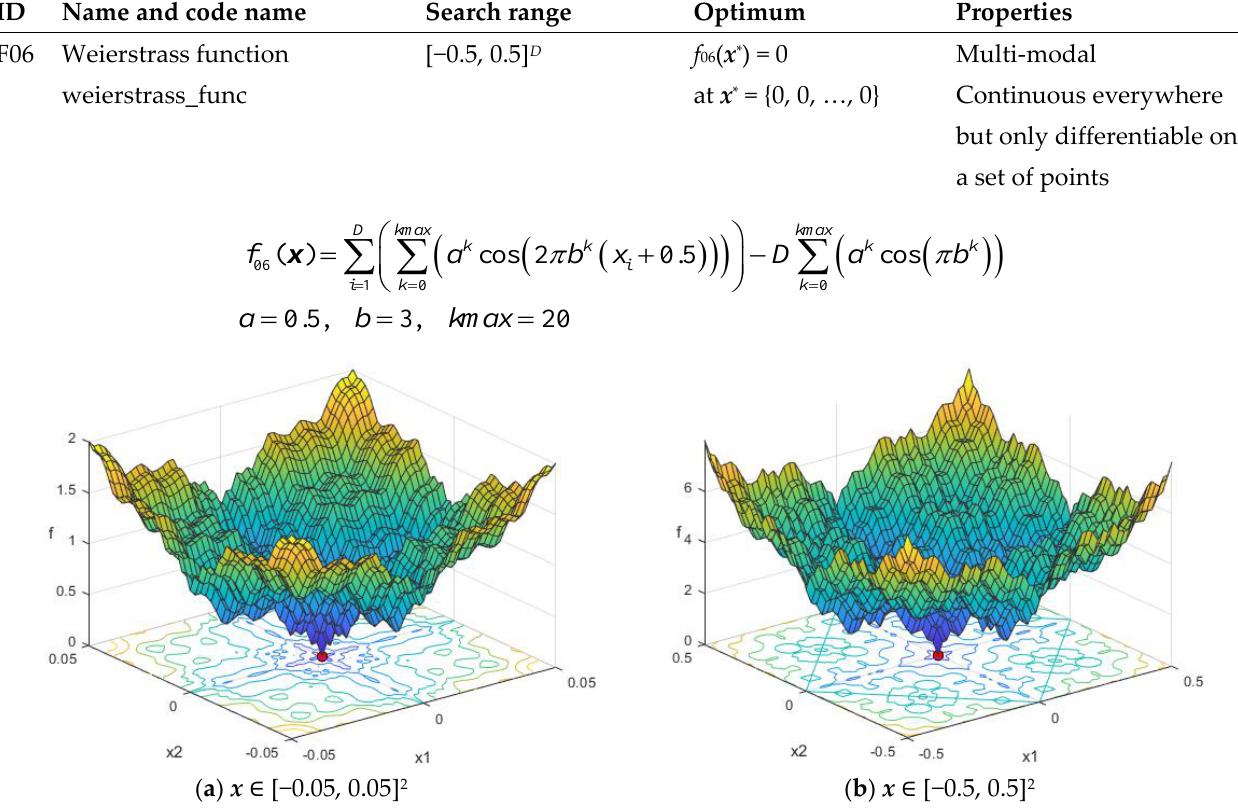
Figure A6. Weierstrass function in two dimensions.